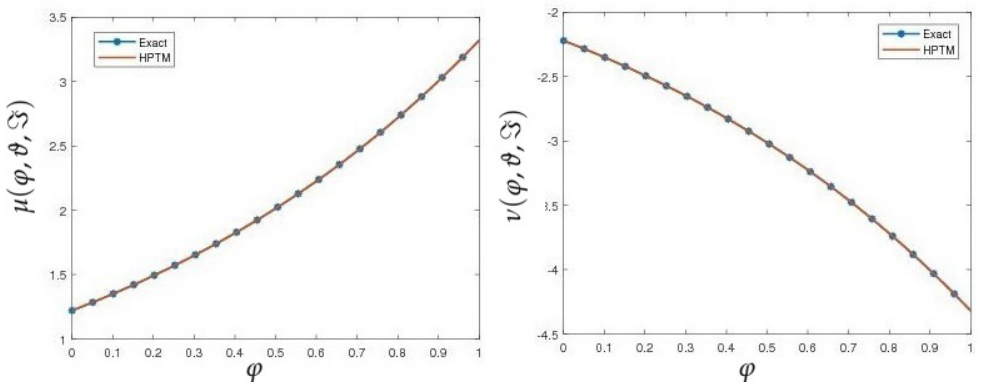
Figure 1. The exact and approximate solution graphs of µ ( ϕ , ϑ ) and ν ( ϕ , ϑ ) , Example